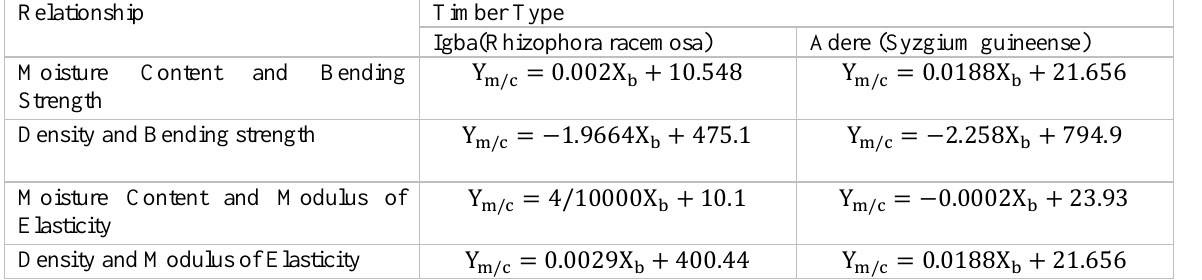
Equations relating Mechanical and Physical properties of timber